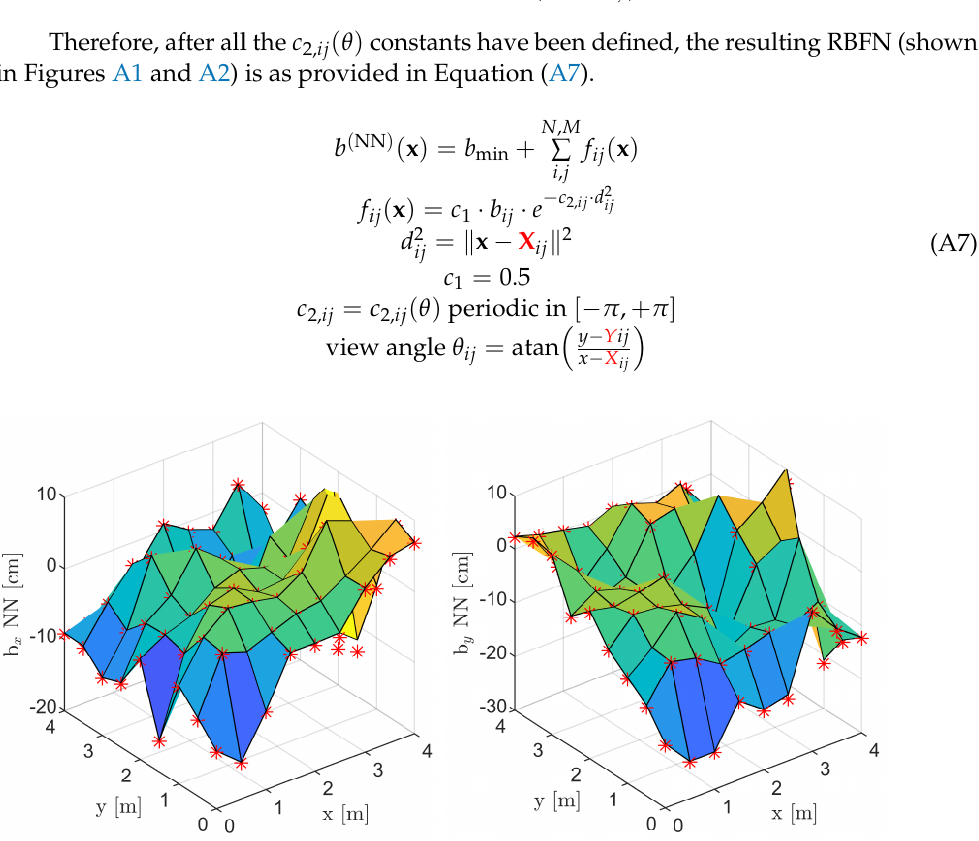
Figure A1. RBFN of bias values on marker points (red stars) for estimating the position of the x ( left ) and y ( right )